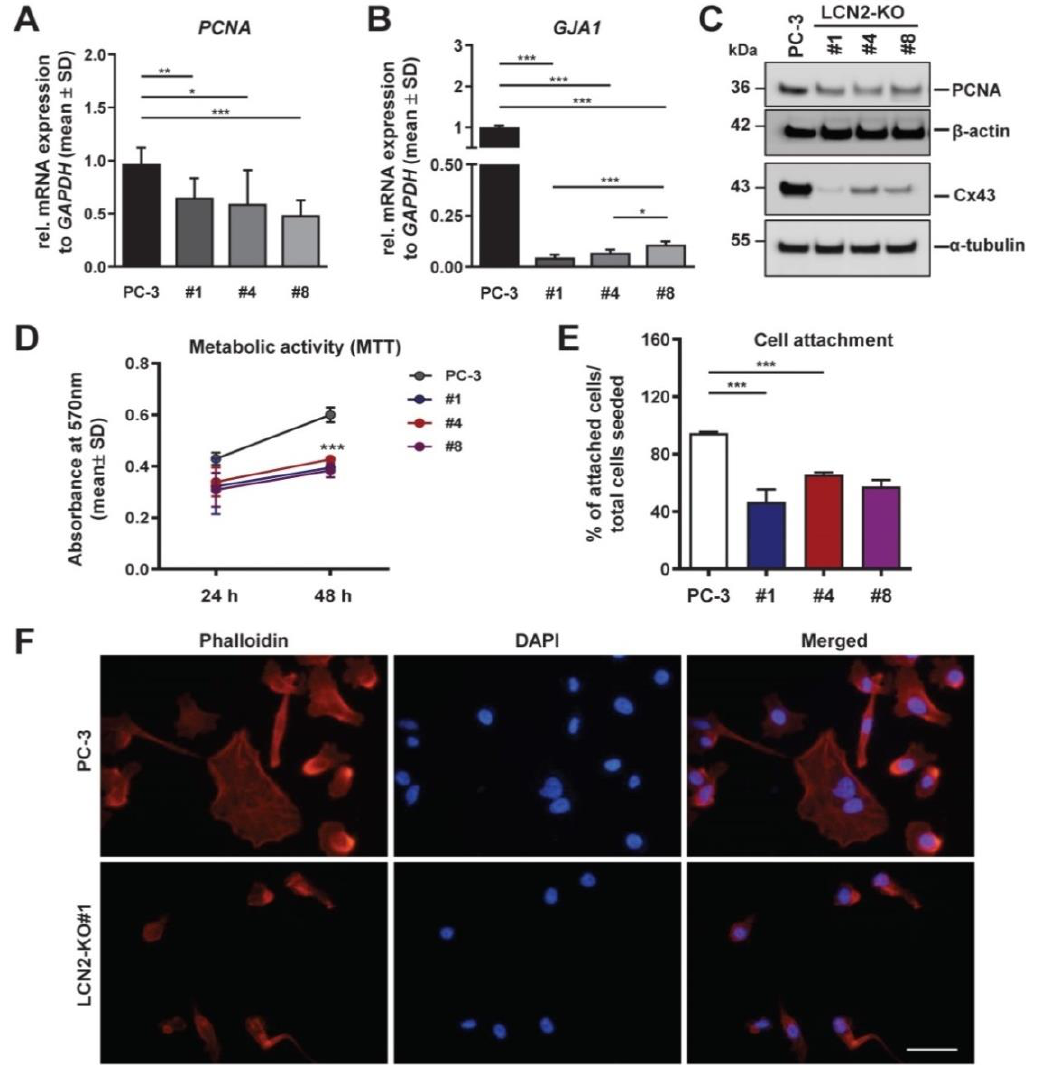
Figure 4. LCN2 deficiency in PC-3 cells results in changes in proliferation, adhesion, and cytoskeleton rearrangement. Quantitative mRNA expression analysis of ( A ) PCNA and ( B ) GJA1 was performed in PC-3 and LCN2-KO (#1, #4, #8) cells grown in basal conditions (n = 3). Both markers were significantly reduced in all analyzed LCN2-KO cells compared to parenteral PC-3 cells. mRNA expression was normalized to GAPDH and are given in relation to parenteral PC-3 cells. Differences between the groups reaching significance are marked by asterisks (* p < 0.05, ** p < 0.01, *** p < 0.001). ( C ) Western blot analysis confirmed reduction in PCNA and Cx43 protein expression in LCN2-KO cells compared to PC-3 cells (n = 3). α-tubulin served as an internal loading control. ( D ) Metabolic activity was determined after 48 h in MTT assay (n = 3) and showed significantly reduced metabolic activity of all LCN2-KO cell lines (*** p < 0.001) compared to PC-3 cells. ( E ) Indirect cell attachment assay was performed as described in the Material and Methods section. Bars show the percentage of attached cells to total cells seeded (n = 3). All statistical values shown represent the comparison of LCN2- KO cell lines to the parenteral PC-3 cells. Differences between the groups reaching significance are indicated as *** p < 0.001. Note that all LCN2-deficient cell lines show significant reduction in cell attachment. ( F ) F-actin stress fibers were stained with Phalloidin-Rhodamine (red) in PC-3 and LCN2-KO#1 cells (n = 2). Nuclei were counterstained with DAPI (blue). Magnification: 400×, scale bar: 50 µm.